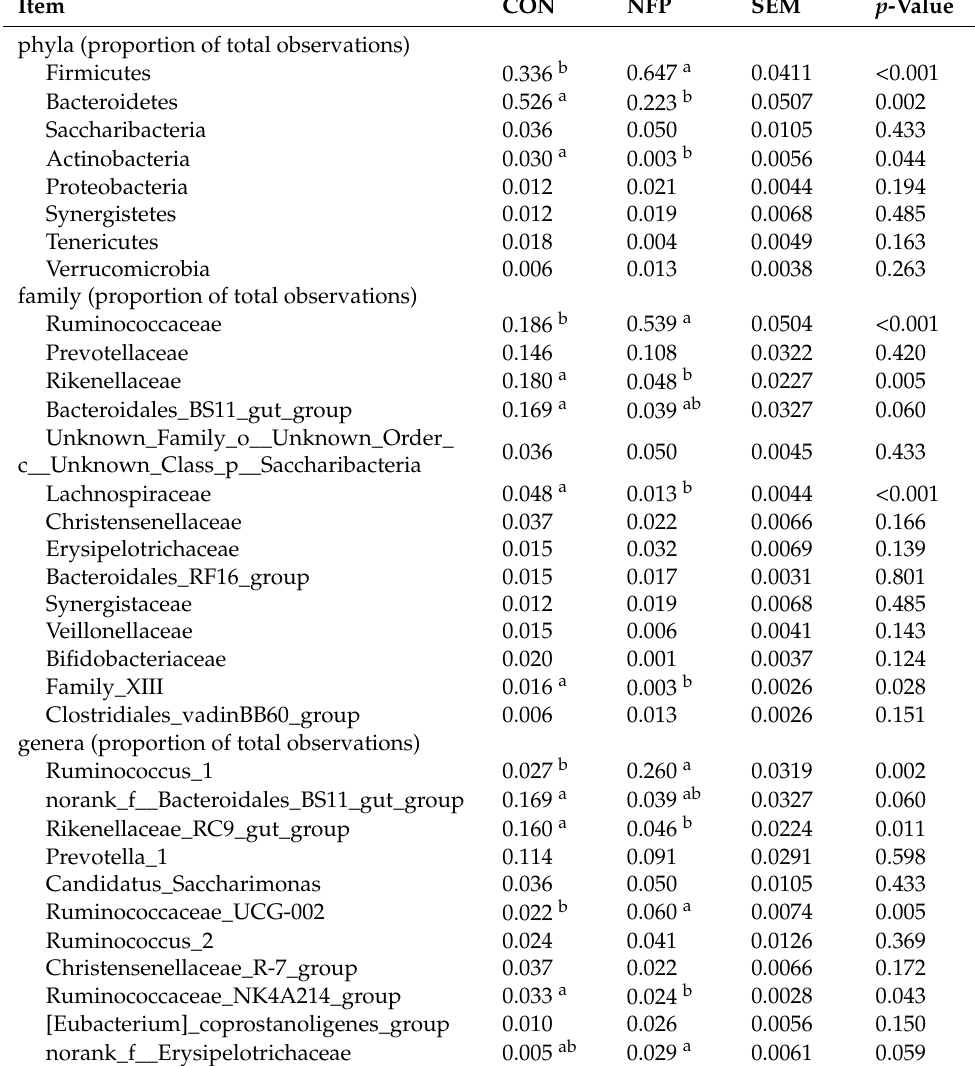
Figure 5. Statistical analysis of different bacterial taxa at the family level by Student’s t ‐ test in Exp. 2 (* 0.01 < p ≤ 0.05, ** 0.001 < p ≤ 0.01, *** p ≤ 0.001).